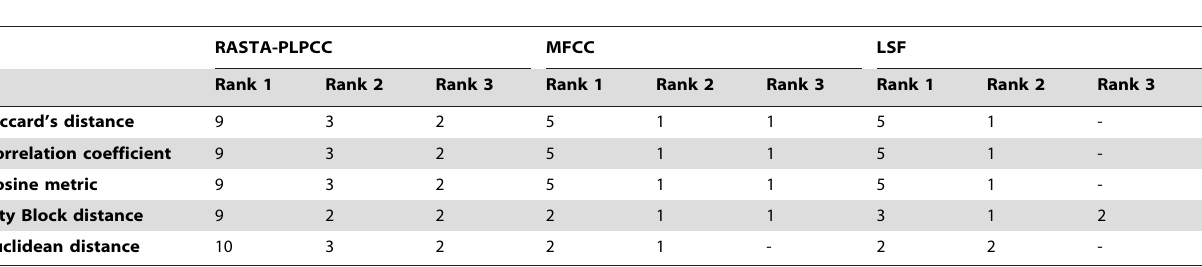
Table 2. The total number of correct matches in the first three ranks given by the five similarity indices for each spectral feature extraction method.